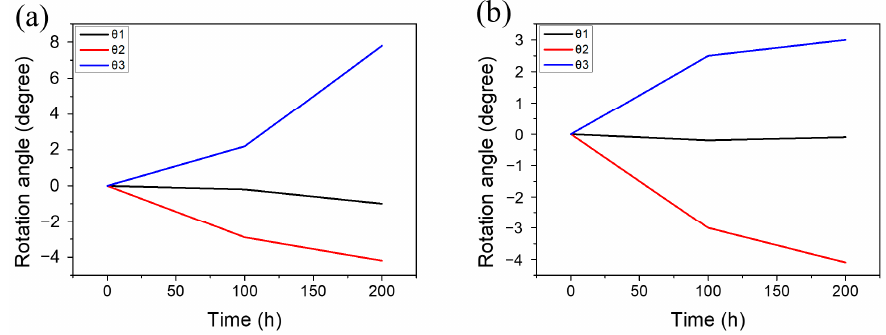
Figure 3. The angle evolution of ( a ) the yellow grain and ( b ) the purple grain. θ 1, θ 2 and θ 3 represent the angle between the current flow direction and the a-, b- and c-axes, respectively.